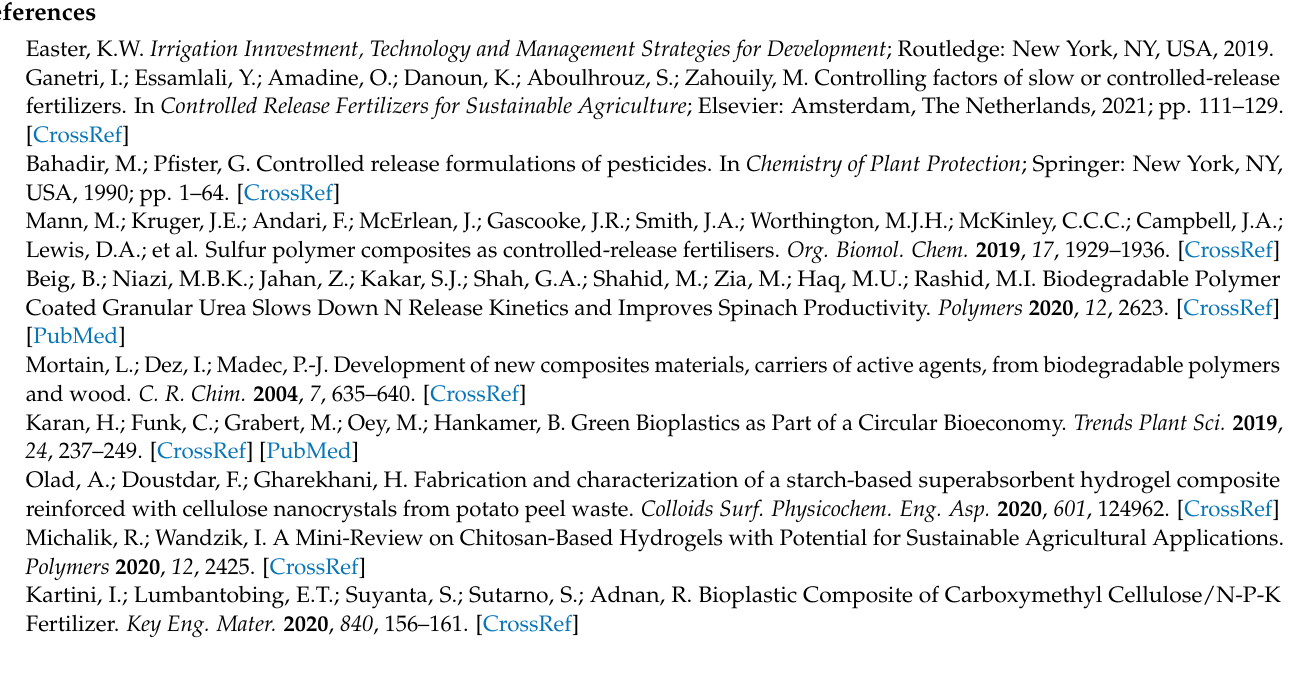
Figure S5: Biodegradability photographs of bioplastics with 1.0 wt% ZnO nanoparticles processed at 110 ◦